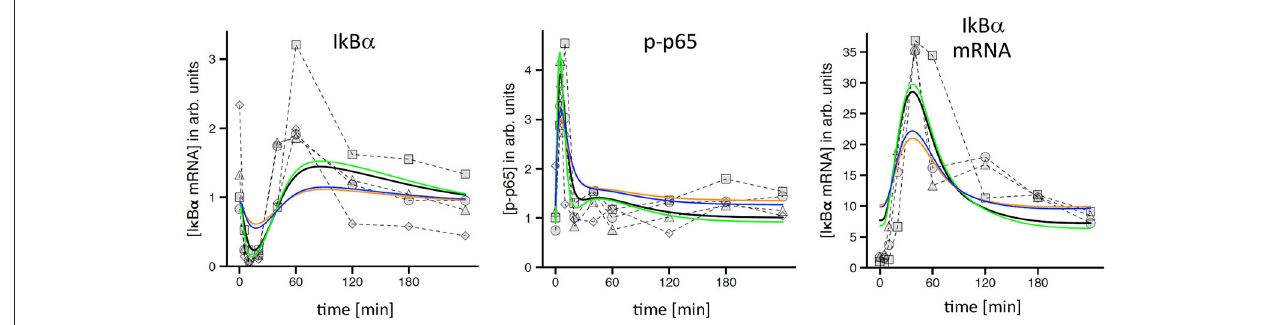
FIGURE 2 | TNF-induced NF- κ B response in Hepa1-6 cells and model simulations. Measured time courses of I κ B α , phospho-p65, and I κ B α -mRNA after administration of 10 ng/ml TNF (symbols connected by dashed lines indicate replicates from independent experiments). Corresponding simulations (black lines) were obtained from a model that was originally created and calibrated for murine primary hepatocytes and only slightly readjusted to fit the Hepa1-6 data (Beuke et al., 2017). Yellow lines: simulations after reduction of TNFR1 by a factor of 2.5. Blue lines: simulations after adjustment of IKK expression. Green lines: simulations after adjustment of TNF/TNFR1